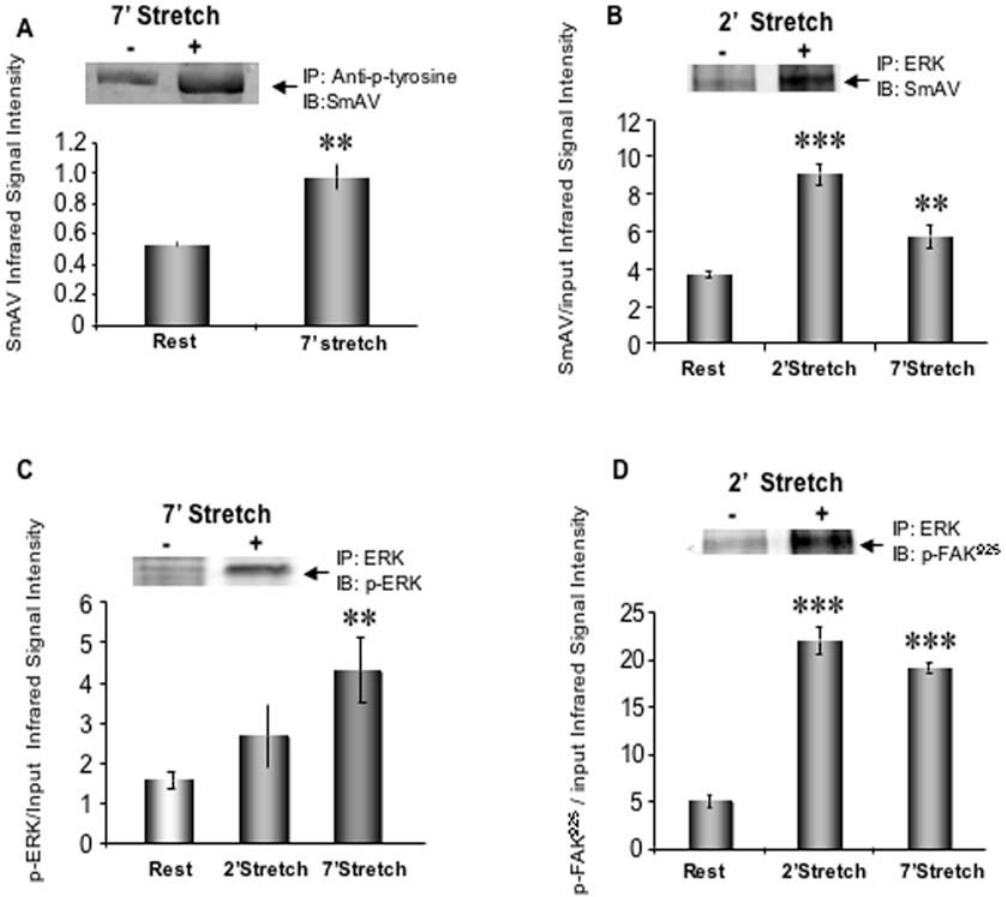
Figure 8. SmAV co-immunoprecipitates with phosphotyrosine, ERK and FAK. A. Myometrial SmAV associates with tyrosine- phosphorylated proteins in a stretch-dependent manner. Stretch and unstretched term pregnant human uterine smooth muscle homogenates were immunoprecipitated (IP) with anti-phospho-tyrosine antibody and immunoblotted (IB) with SmAV antibody. **p , 0.01 compared to unstretched control samples. The insert is a typical SmAV western blot with IP samples. n=5. B. Myometrial SmAV associates with ERK protein in a stretch- dependent manner. Stretched and unstretched term samples were immunoprecipitated with anti- ERK antibody and immunoblotted with anti-SmAV antibody. SmAV densitometry was normalized to input signals. n=6. **p , 0.01, ***p , 0.001. C. Confirmation of stretch induced ERK phosphorylation in human myometrium. Stretch and unstretched samples were immunoprecipitated with anti- ERK antibody and immunoblotted with phospho-ERK antibody. The p-ERK2 infrared signals were also normalized to input signals. n=6. **p , 0.01. D. Myometrial ERK associates with FAK in a stretch-dependent manner. Stretch and unstretched samples homogenates were immunoprecipitated with anti- ERK antibody and immunoblotted with phospho-FAK 925 antibody. The p-FAK infrared signals were normalized to input signals. n=6. ***p , 0.001